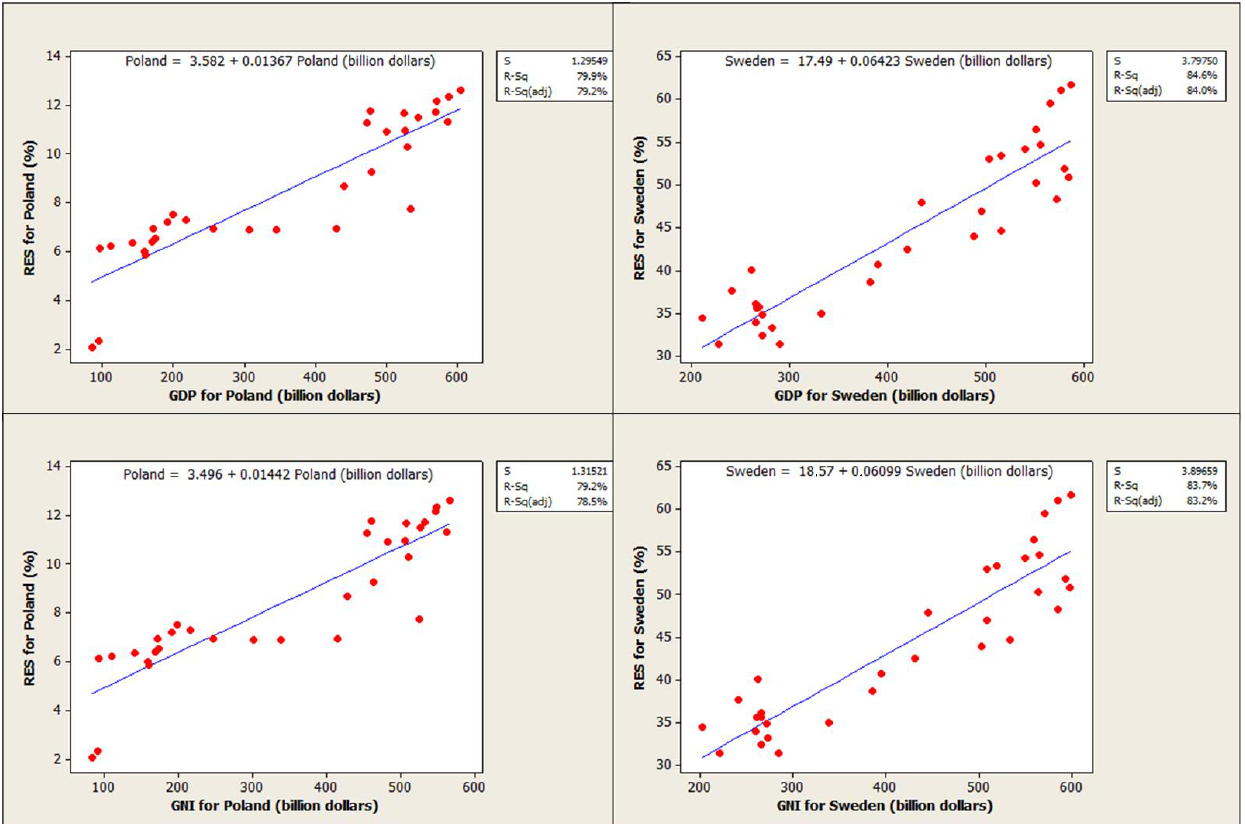
Figure 3. Correlations between GDP, GNI (in billion USD), and RES for Poland and Sweden. Correlations between GDP, GNI, and RES for both Poland and Sweden are very high. Relations between RES and GDP for Poland and Sweden (79.9% and 84.6%, respectively) indicate a good fit between the analyzed variables. The standard deviation for Poland and Sweden (S = 1.29549 and S = 3.79750, respectively) shows that GDP values are not dispersed widely around its average. Correlations between RES and GNI for Poland and Sweden (79.2% and 83.7% respectively) also point at an accurate fit between the variables. The GNI values for Poland and Sweden are not so dispersed around its average (S = 1.31521 and S = 3.89659, respectively), as is shown in Figure 3.